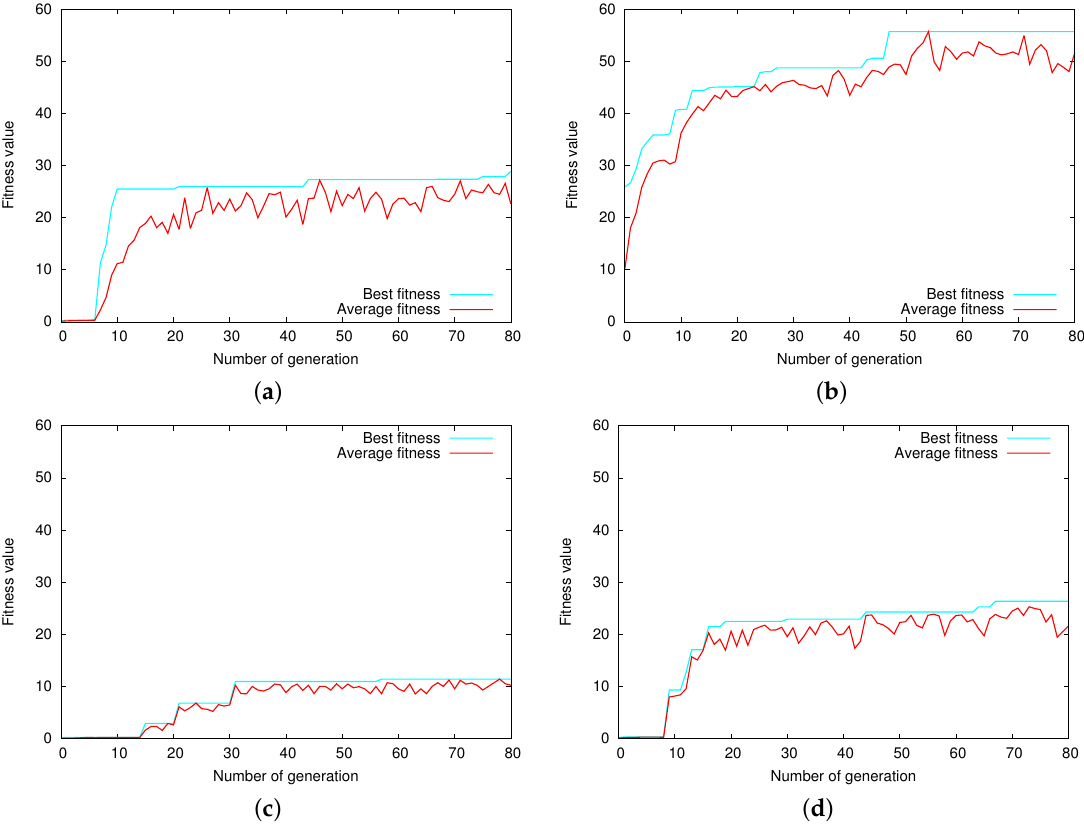
Figure 6. Fitness evolution of the individuals in the populations using GARSUD. ( a ) Four RSUs in Madrid; ( b ) 9 RSUs in Madrid; ( c ) 4 RSUs in Valencia; ( d ) 9 RSUs in